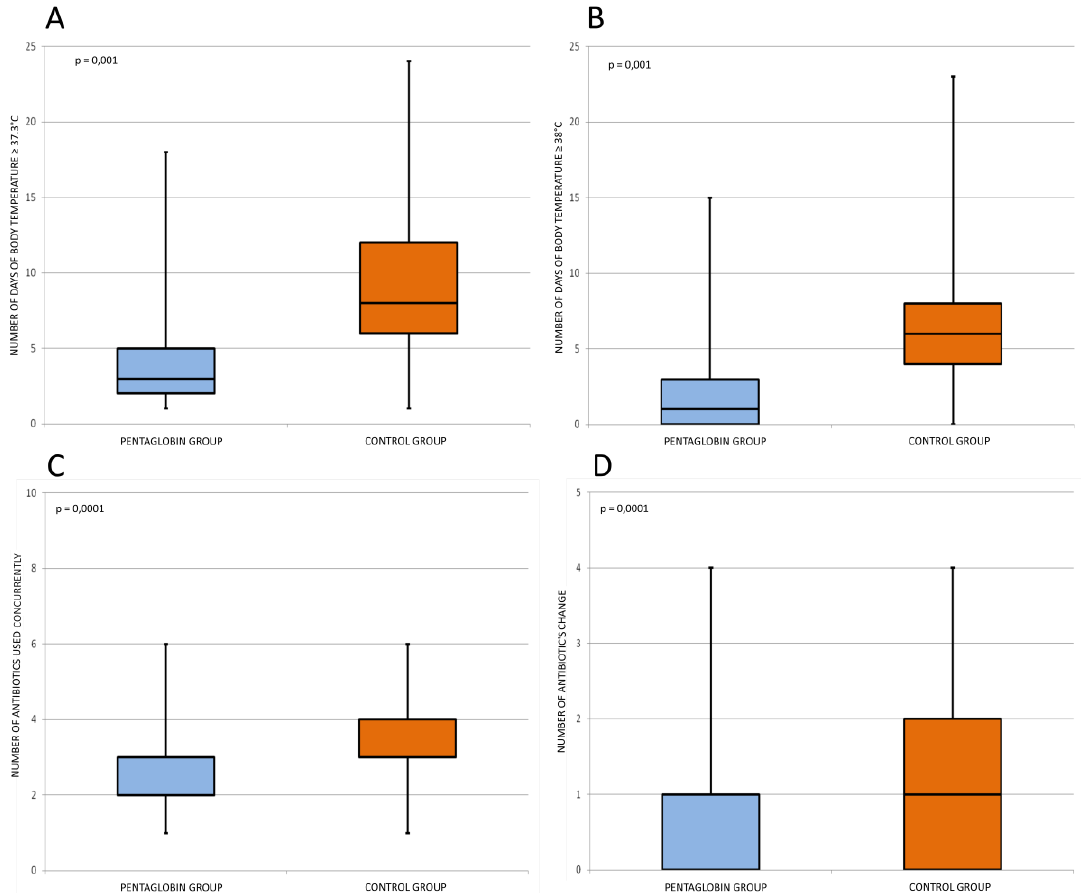
Figure 6. Box plots of secondary outcomes. Box-plot analysis showed a statistically significant di ff erence ( p < 0.001) between the study groups for the number of days with body temperature ≥ 37.3 ◦ C ( A ) and ≥ 38 ◦ C ( B ). Statistically significant di ff erences ( p < 0.0001) between two study groups were found in the number of antibiotics used ( C ) and the number of changes of antibiotics because of the failure of treatment ( D ) .